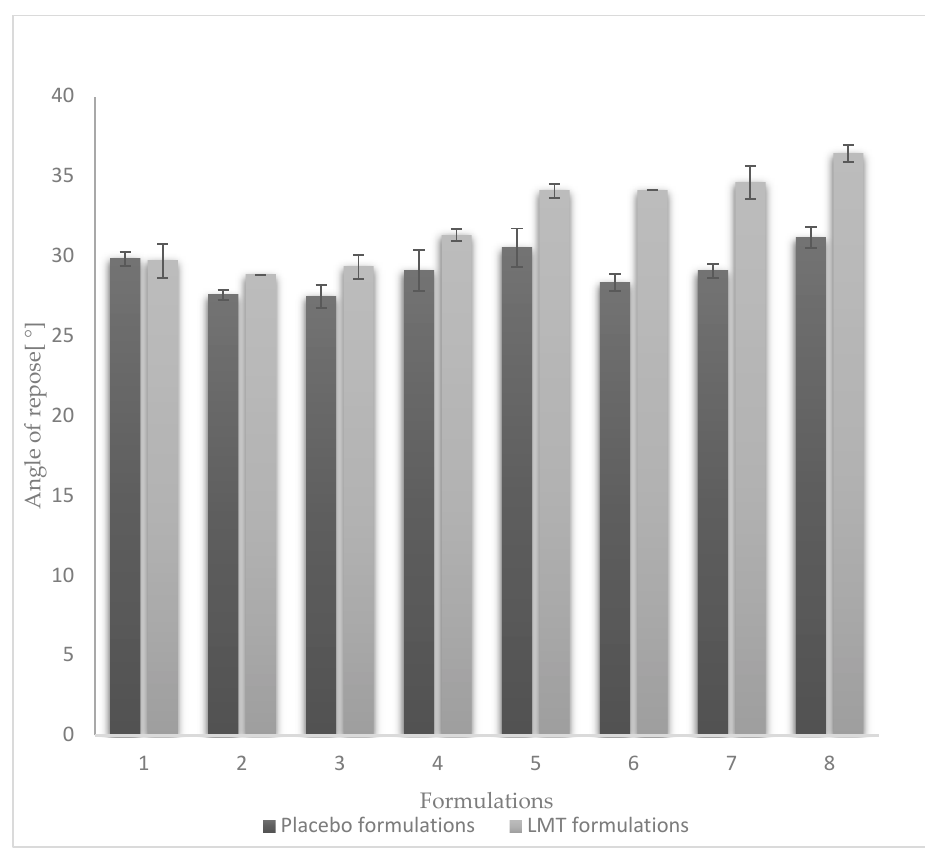
Figure 2. Angle of repose placebo formulations (F1–F8) and formulations with LMT (T1–T8).